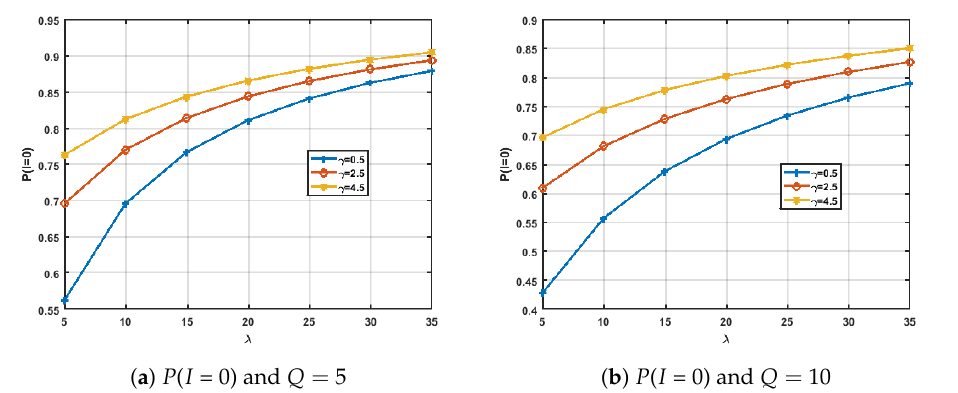
Figure 3. The effect of increasing demand ( λ ) for different γ values under deterministic order size.